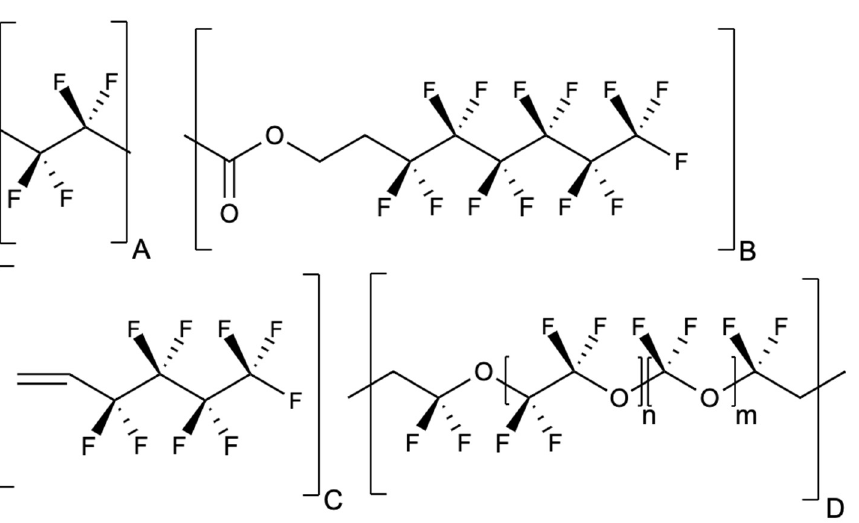
Figure 2. Structures of several PFAS food contact materials. ( A ) shows the structure of polytetrafluoroethylene or PTFE, used for coatings on cookware, pans, and utensils. ( B ) shows the 6:2 fluorotelomer structure present in multiple food contact substances approved by the U.S. FDA since 2008, which are undergoing the voluntary phase-out starting in July 2020 [41]. ( C ) shows the fluorinated monomer ingredient that, in combination with perfluoroethylene and ethylene, is used to manufacture a PFAS-based terpolymer approved in 2018 (U.S. FDA food contact notification approval No. 1914). ( D ) shows the fluorinated section of a perfluoroether polymer approved in 2010 (U.S. FDA food contact notification approval No. 962).